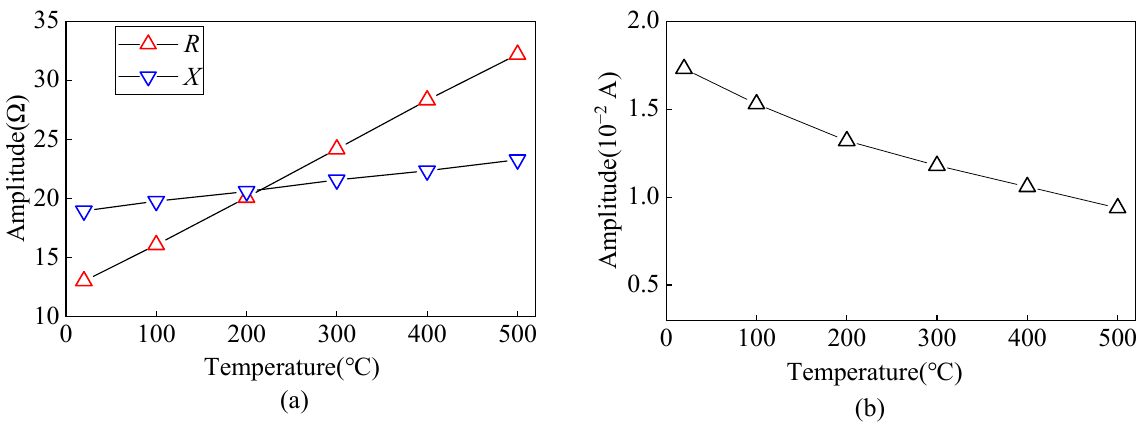
Figure 6. Variation curve of ( a ) equivalent impedance and ( b ) excitation current from the angled SV wave EMAT coil at different temperatures.